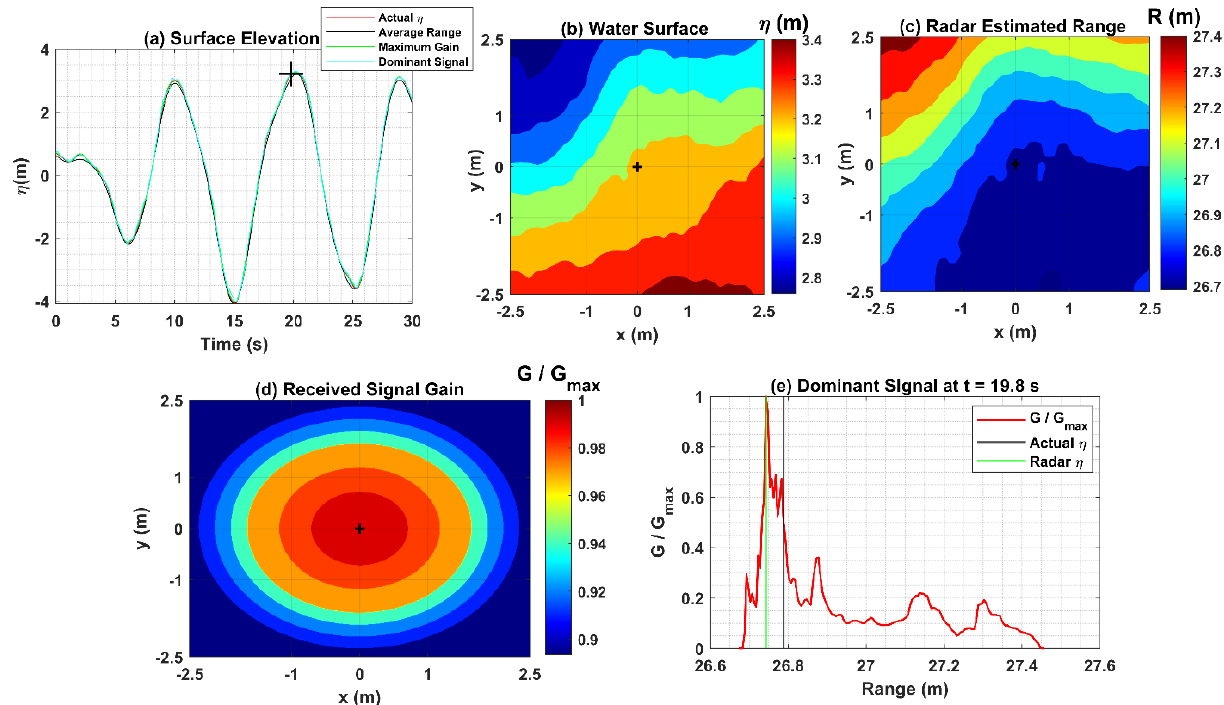
Figure 9. Radar dominant signal processing for a crest elevation of 3.2 m occurred at 19.8 s: ( a ) time series plots of actual surface elevations and that from the Radar signals; ( b ) water surface covered by the Radar footprint (5 m × 5 m); ( c ) Radar estimated ranges over its footprint; ( d ) normalized received signal gain over the Radar footprint; ( e ) normalized dominant signal gain as a function of range.